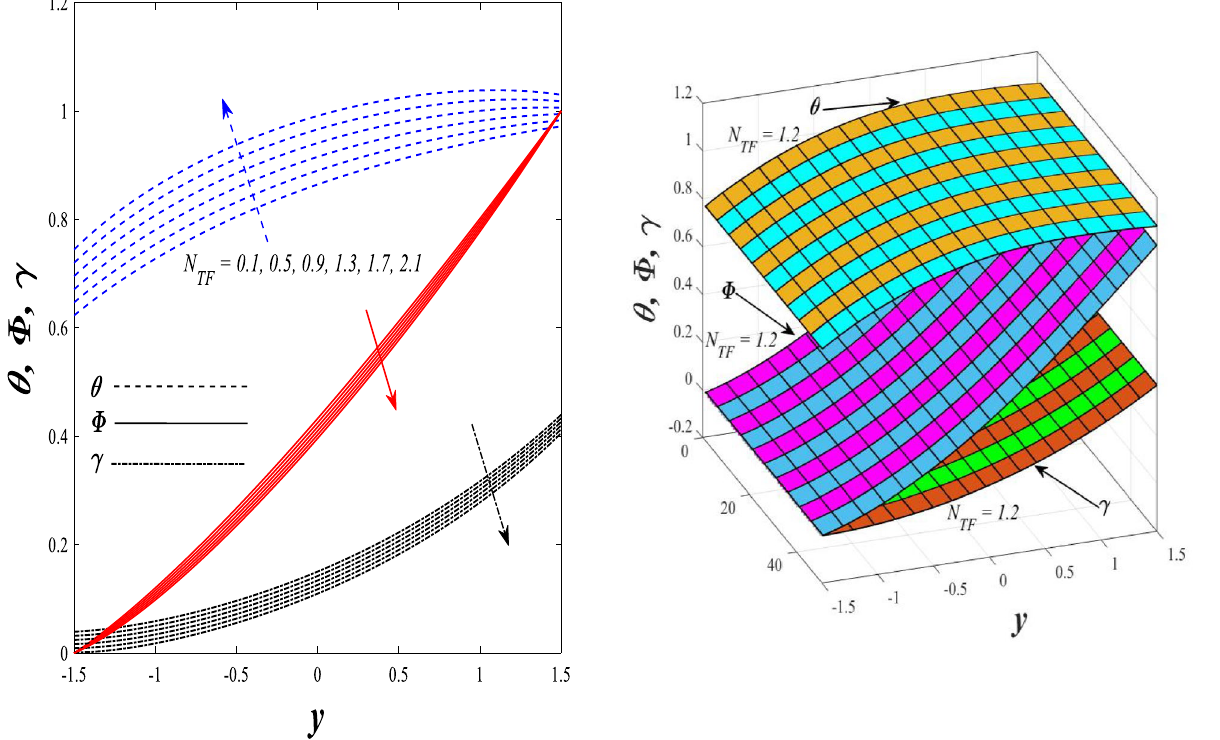
Figure 16. Effect of Dufour parameter N T F on thedistributions of both temperature, solutal concentration and nanoparticles volume fraction 2D and 3D.